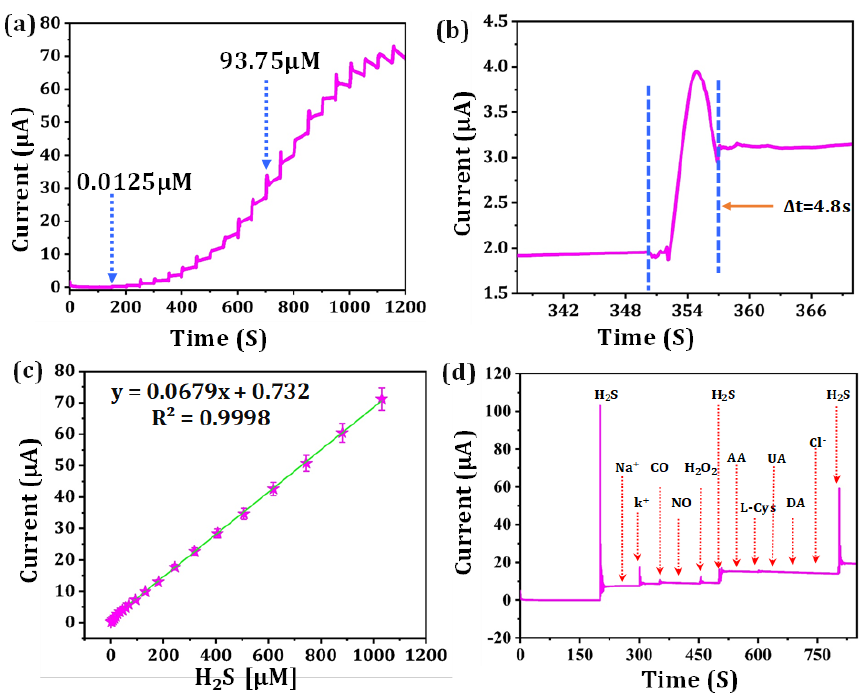
Figure 5. ( a ) Amperometry (i-t) response of the PtNi/SPE with different concentrations of sulfide (0.625 – 41.2 µM) in 0.05 M PB (pH 7.0) at various working potential ranges (0.49, 0.69, 0.72, and 0.22